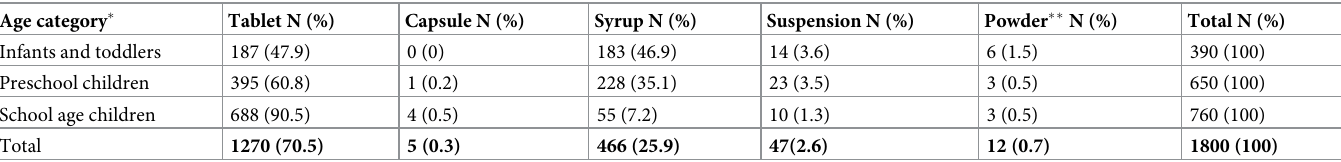
Table 1. Type of oral dosage forms administered to children under the age of 12 years.